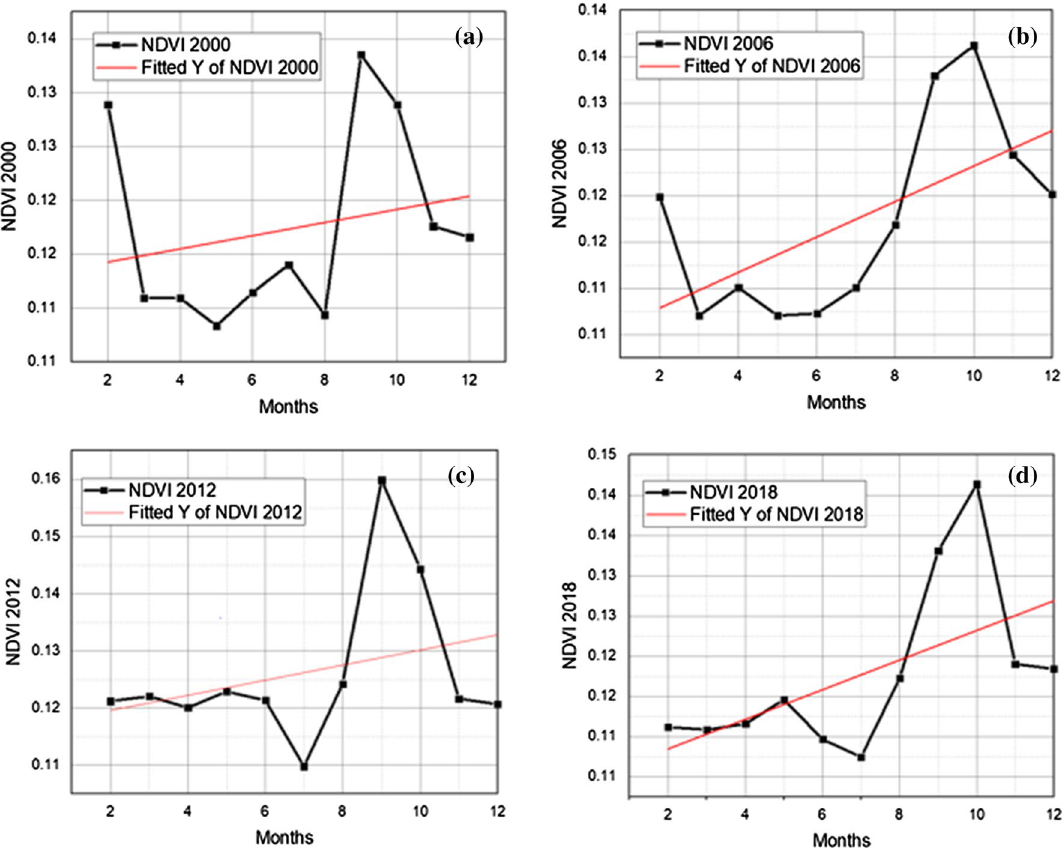
Fig. 6 Temporal variation of NDVI trend from 2000 to 2018. a NDVI trend from 2000 b NDVI trend from 2006 c NDVI trend from 2012, d NDVI trend from 2018 in Niger